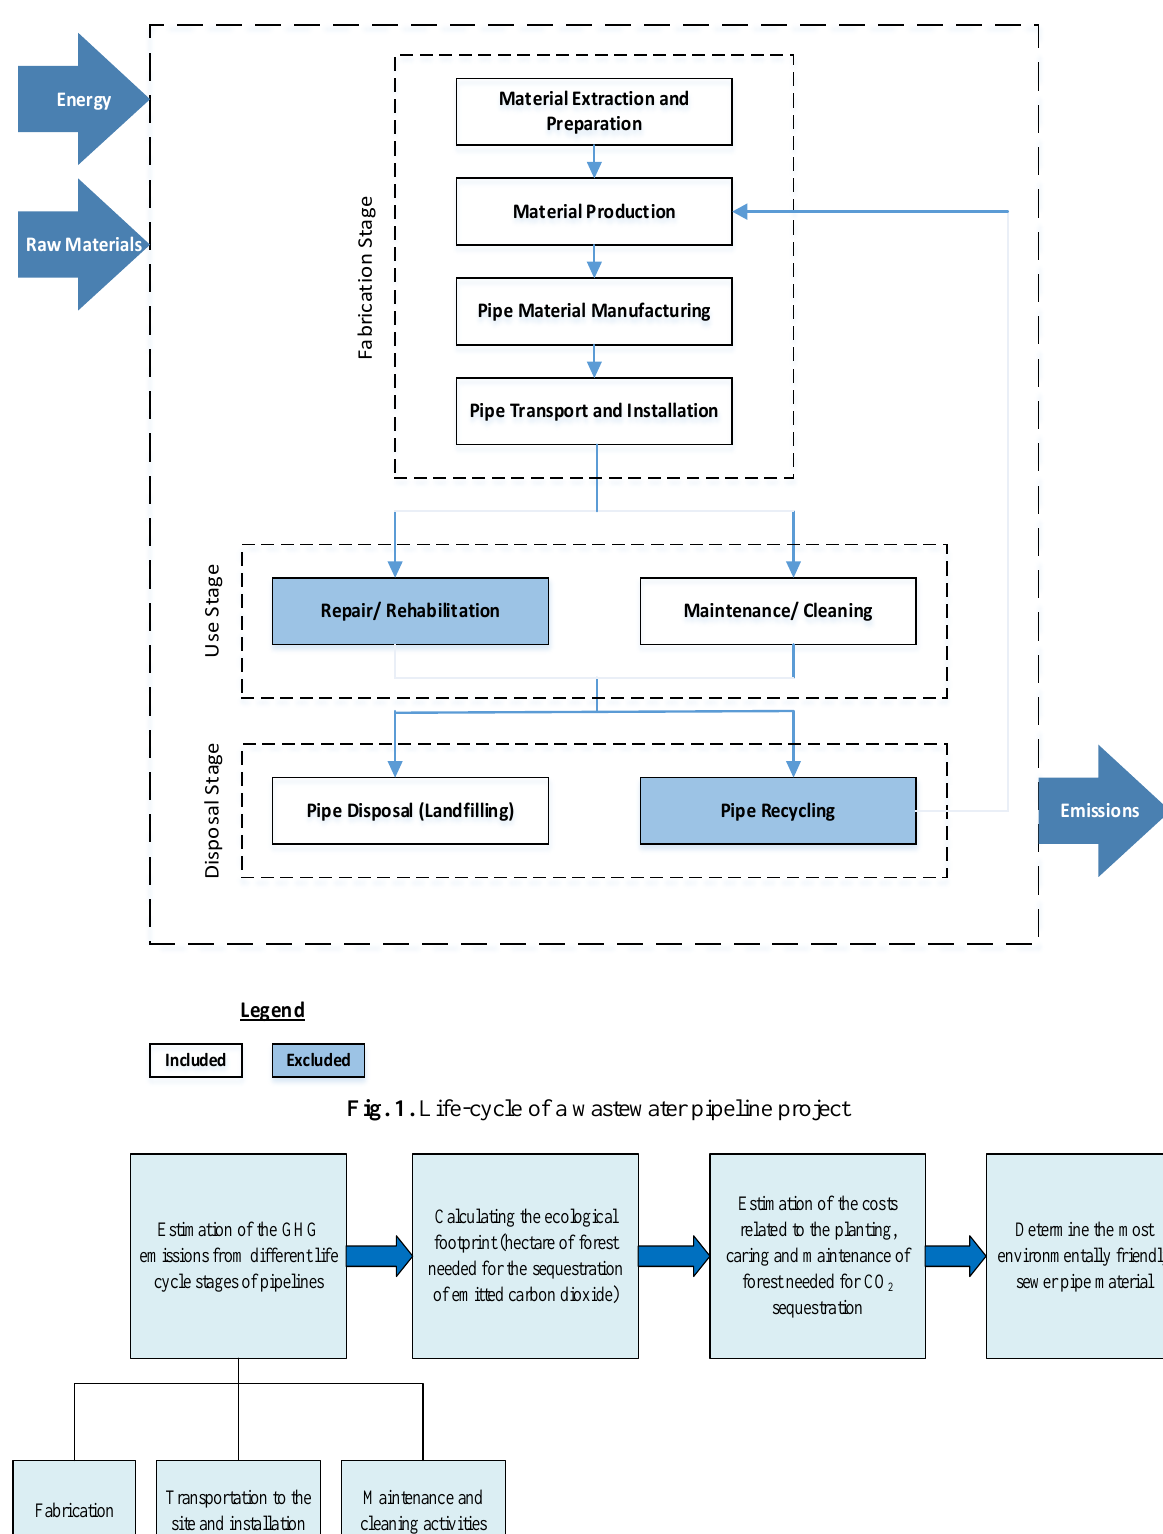
Fig. 2. Flowchart of the proposed